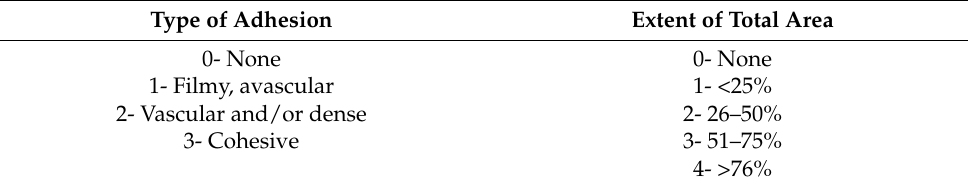
Table 1. Adhesion scoring system.